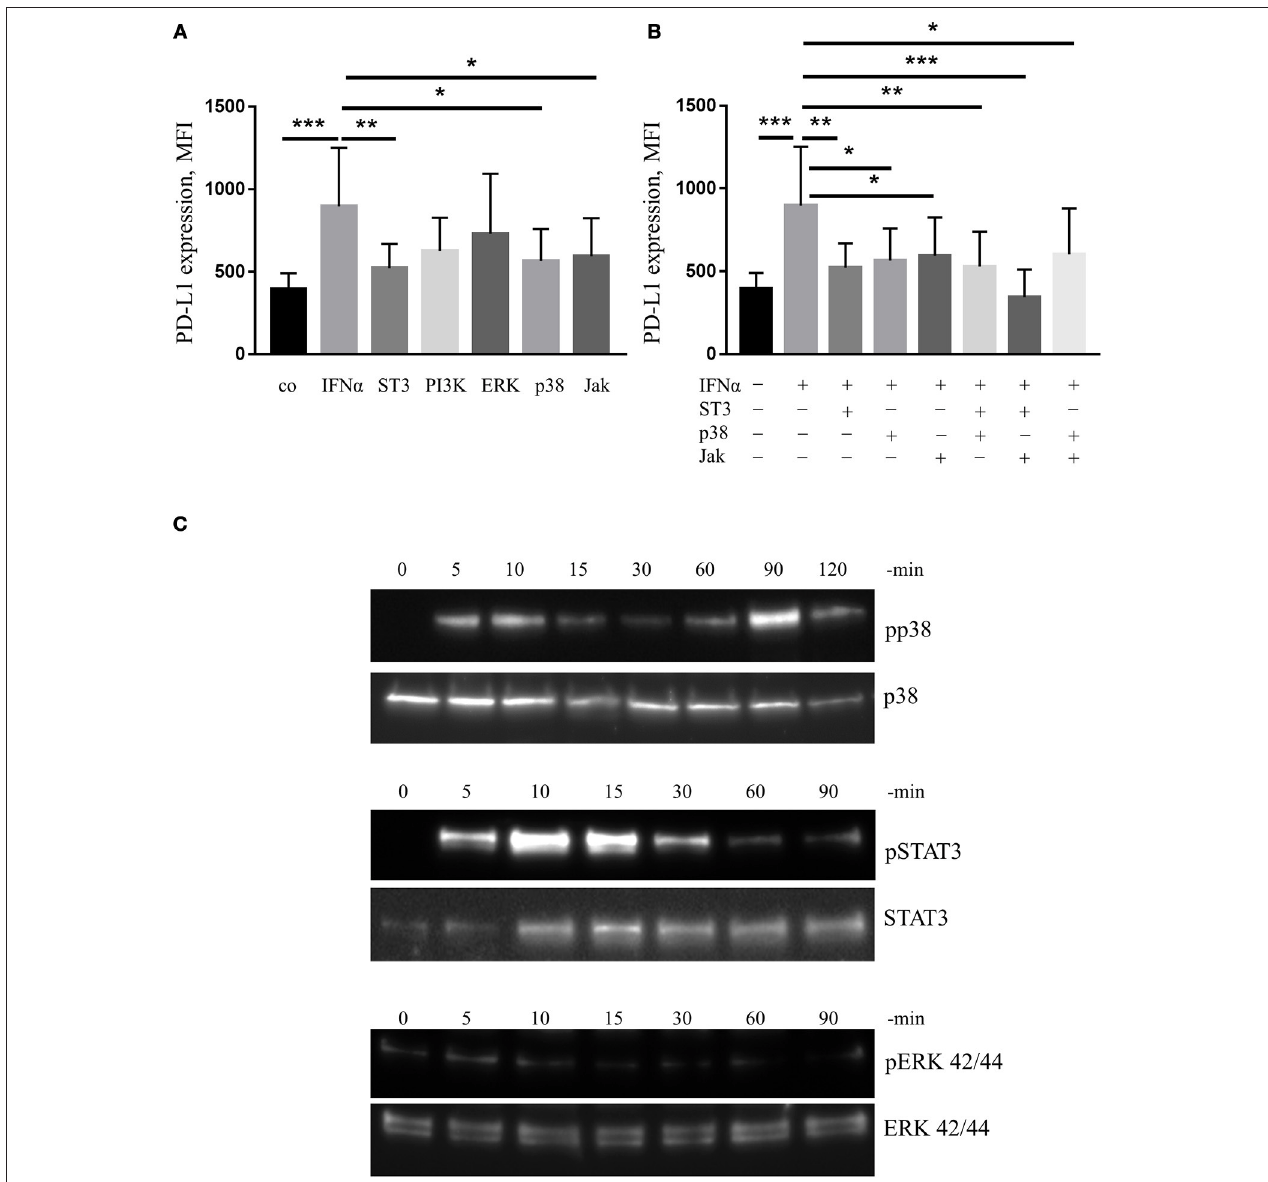
FIGURE 6 | IFN α up-regulates PD-L1 expression in mDC in p38/STAT3-dependent manner. (A,B) FACS analysis of PD-L1 expression on mDC activated for 24h with 1,000 U/ml IFN α with or without 1h pre-incubation with signal transduction inhibitors of p38, STAT3 (ST3), PI3K, ERK, p38, and Jak. The results are presented as column bar graphs and statistically analyzed using ordinary one-way ANOVA with the Dunnett’s multiple comparisons post-test, n = 8–10, * p < 0.05, ** p < 0.01, and *** p < 0.001. (C) Western blot analysis of p38, STAT3, and ERK phosphorylation (pp38, pERK, and pSTAT3 for phosphorylated form) in mDC before and after activation for indicated period of time with IFN α